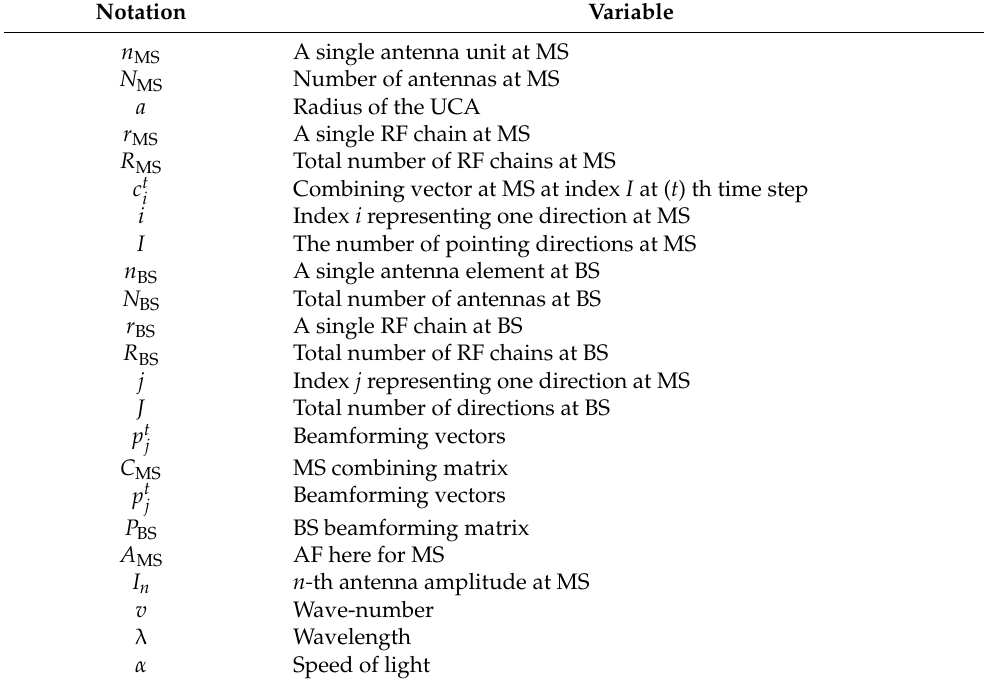
Table 3. List of notations for the beamforming